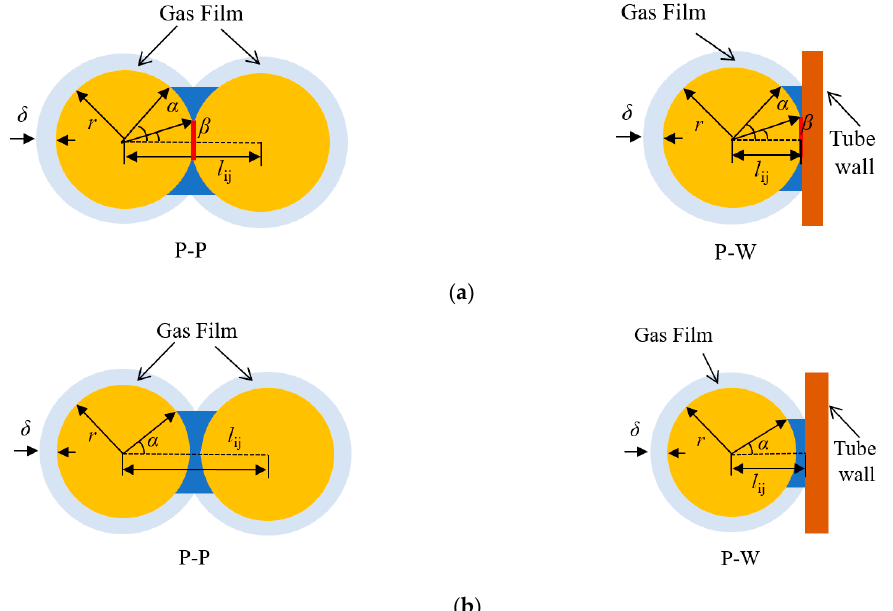
Figure 3. Schematic diagram of thermal conduction resistance calculation parameters: ( a ) physical